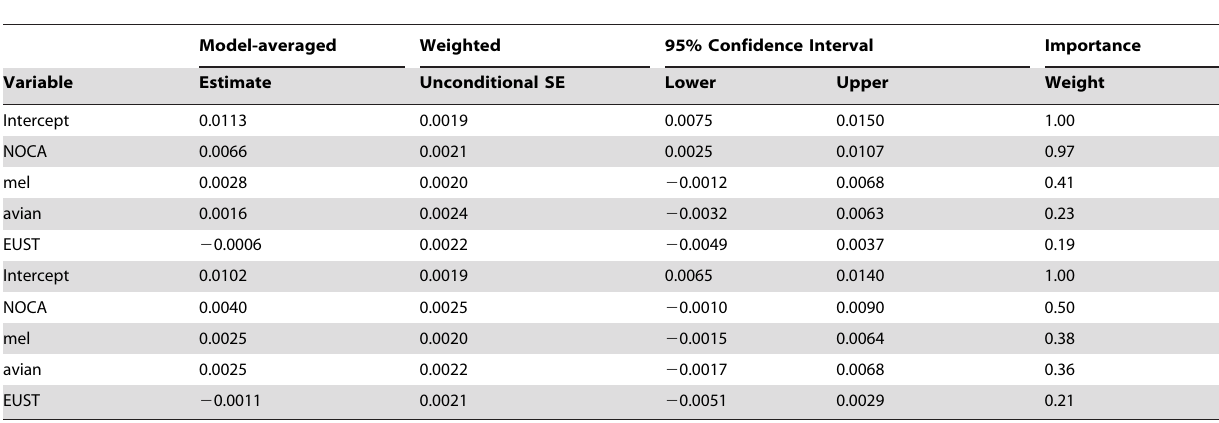
Table 2. Importance weights and results of model averaging for predictor variables in spatial modeling of EEEV exposure risk in sentinel chickens in Walton County, Florida in 2009 and